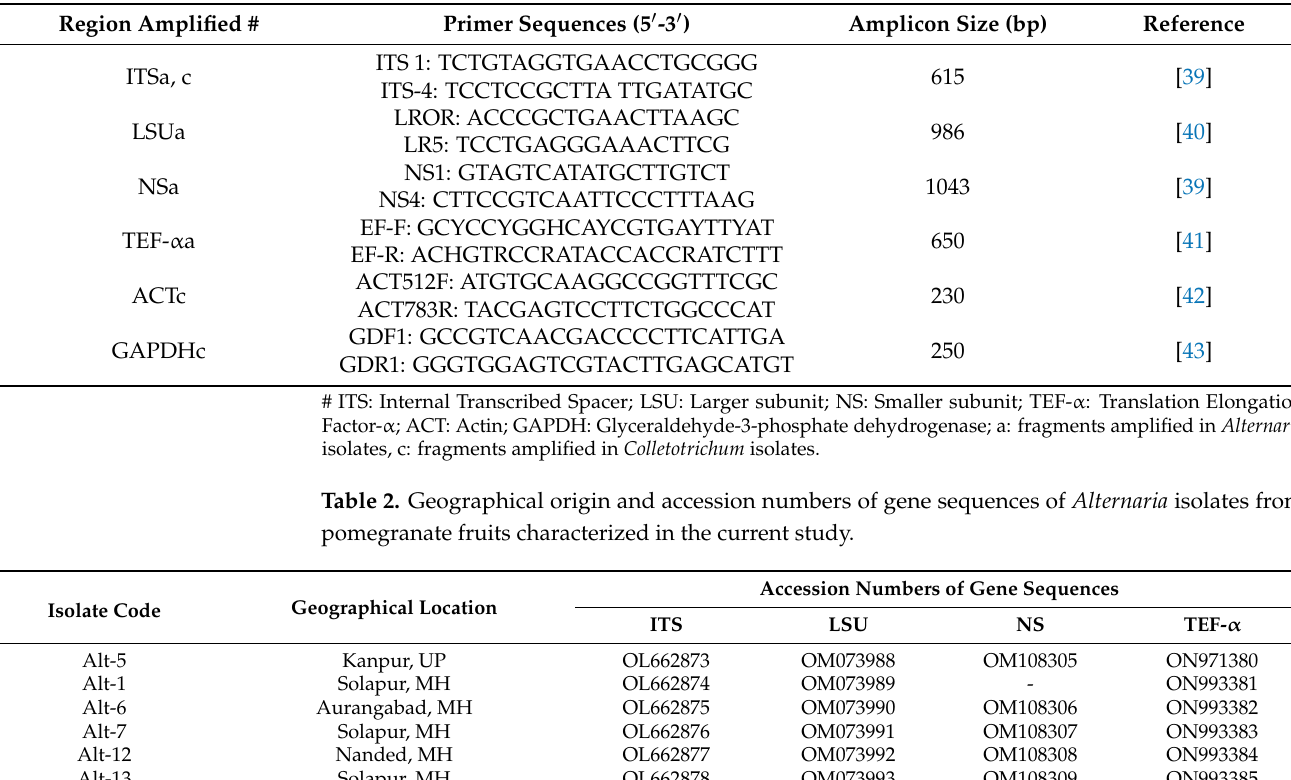
Table 1. Primers used for DNA amplification in the molecular characterization of Alternaria and Colletotrichum isolates.